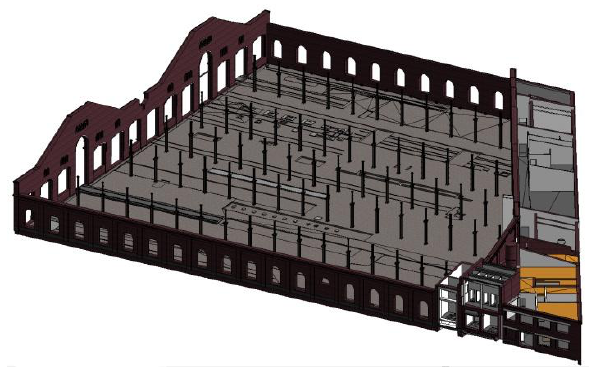
Figure 6. Intermediate model with walls, floor structure and stanchions